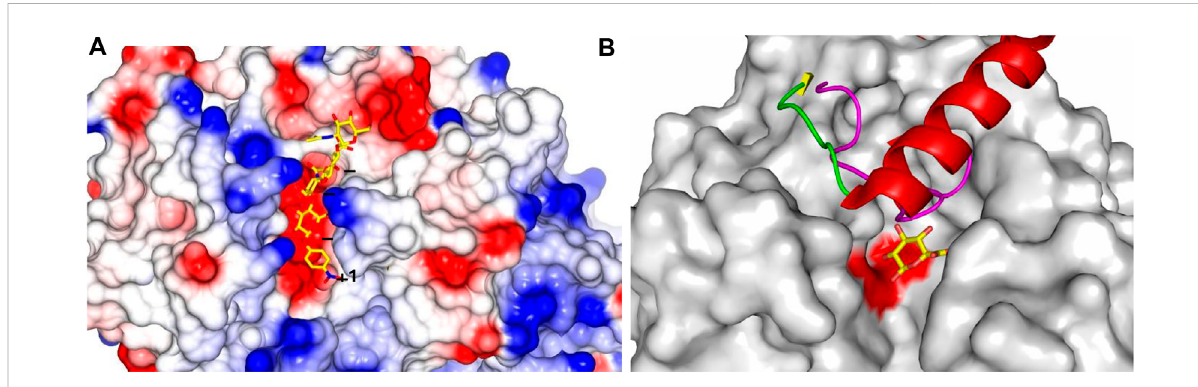
FIGURE 2 HPSE substrate binding site and structural superimposition. (A) hHPSE (electrostatic surface) in complex with a bound tetrasaccharide (our unpublishedwork)instickpresentation(carboninyellow,nitrogeninblueandoxygeninred)spanningthroughbindingsubsites+1, − 1, − 2, − 3(Davies et al., 1997); (B) BpHPSE is illustrated in surface representation with two conserved catalytic glutamate highlighted in red; the loop that forms part of thesubstrate-bindingpocketinAcaGH79iscoloredinmagenta;the6-kDalinkerofhproHPSEisillustratedinribbonrepresentationwith α -helix in red, β -strand in yellow and loop in green; the bound GlcA are colored with carbon in yellow and oxygen in